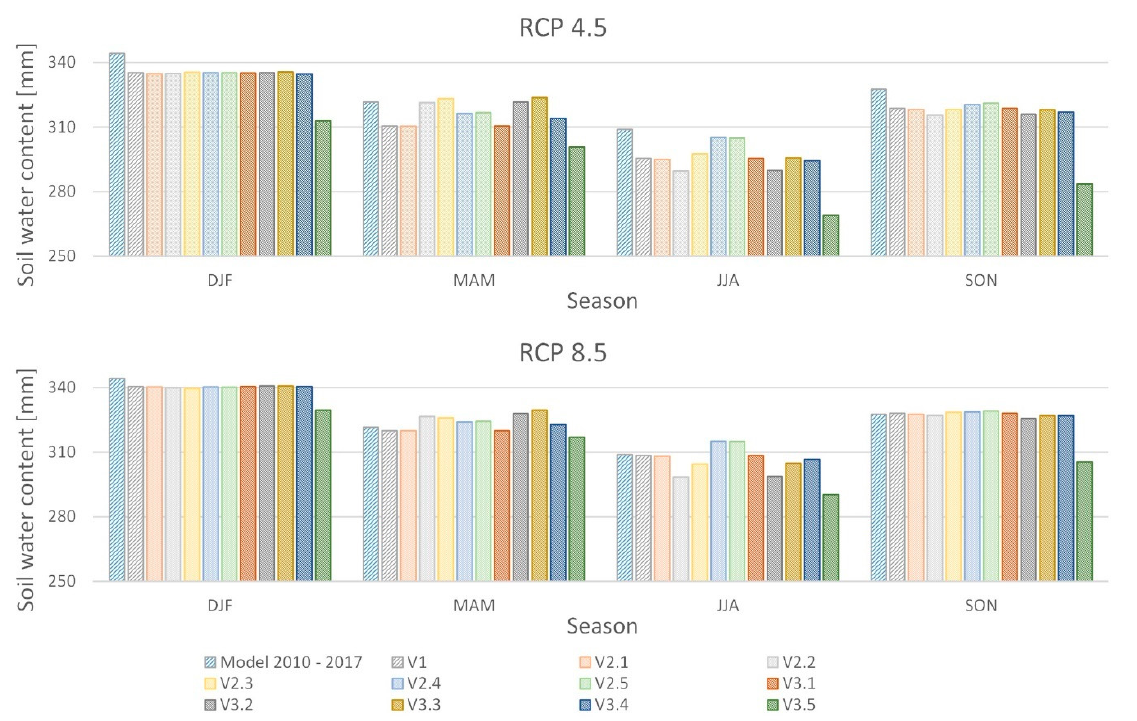
Figure 3. Comparison of the average distribution of soil water content by season for the SWAT 2010–2017 simulation period with variants 1–3 for the RCP 4.5 and RCP 8.5 climate change scenarios, for the years 2041–2050 in the Bystra catchment (author’s own study).